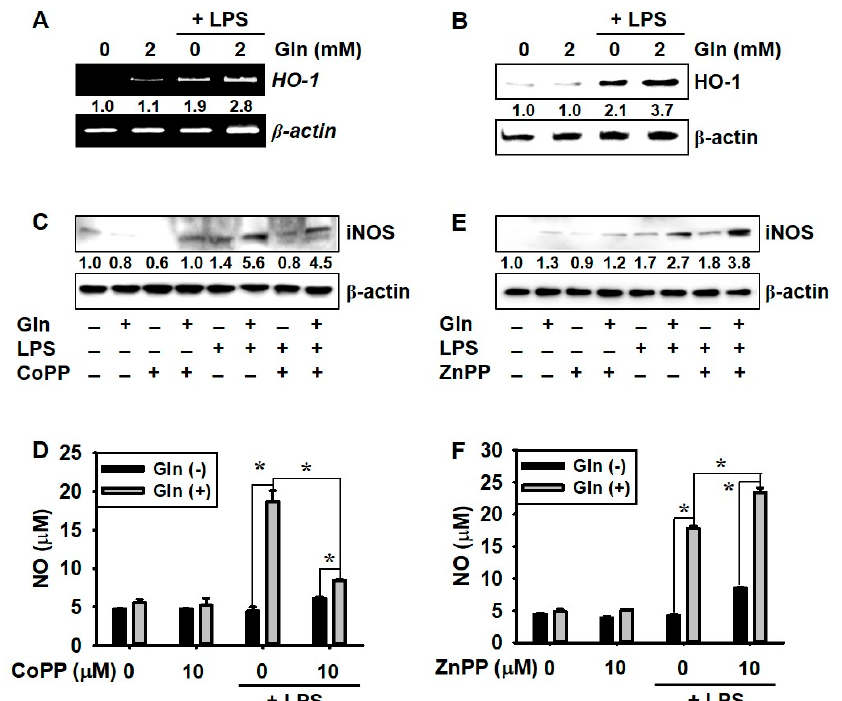
Figure 4. Glutamine (Gln) increases lipopolysaccharide (LPS)-mediated heme oxygenase-1 (HO-1) expression and nitric oxide (NO) production. BV2 microglial cells (1 × 10 5 cells / mL) were incubated in the presence or absence of Gln 2 h before being treated with 500 ng / mL LPS. ( A ) Total mRNA was isolated 6 h after LPS treatment, and RT–PCR for HO-1 was performed. ( B ) In a parallel experiment, protein lysates were prepared at 24 h, and equal amounts of the lysates were resolved on SDS-polyacrylamide gels, transferred to nitrocellulose membranes, and probed with a specific antibody against HO-1. ( C , D ) BV2 microglia cells were pretreated with 10 µ M cobalt protoporphyrin (CoPP) for 1 h and then, incubated with LPS for 24 h, in the presence and absence of 2.0 mM Gln. ( C ) Western blotting was performed to check iNOS expression. ( D ) NO production was measured by Griess reaction. ( E , F ) BV2 microglia cells were pretreated with 10 µ M zinc protoporphyrin (ZnPP) for 1 h, and then incubated with LPS for 24 h in the presence or absence of 2.0 mM Gln. ( E ) Western blotting was performed to check iNOS expression. ( F ) NO production was measured by the Griess reaction. β -Actin was